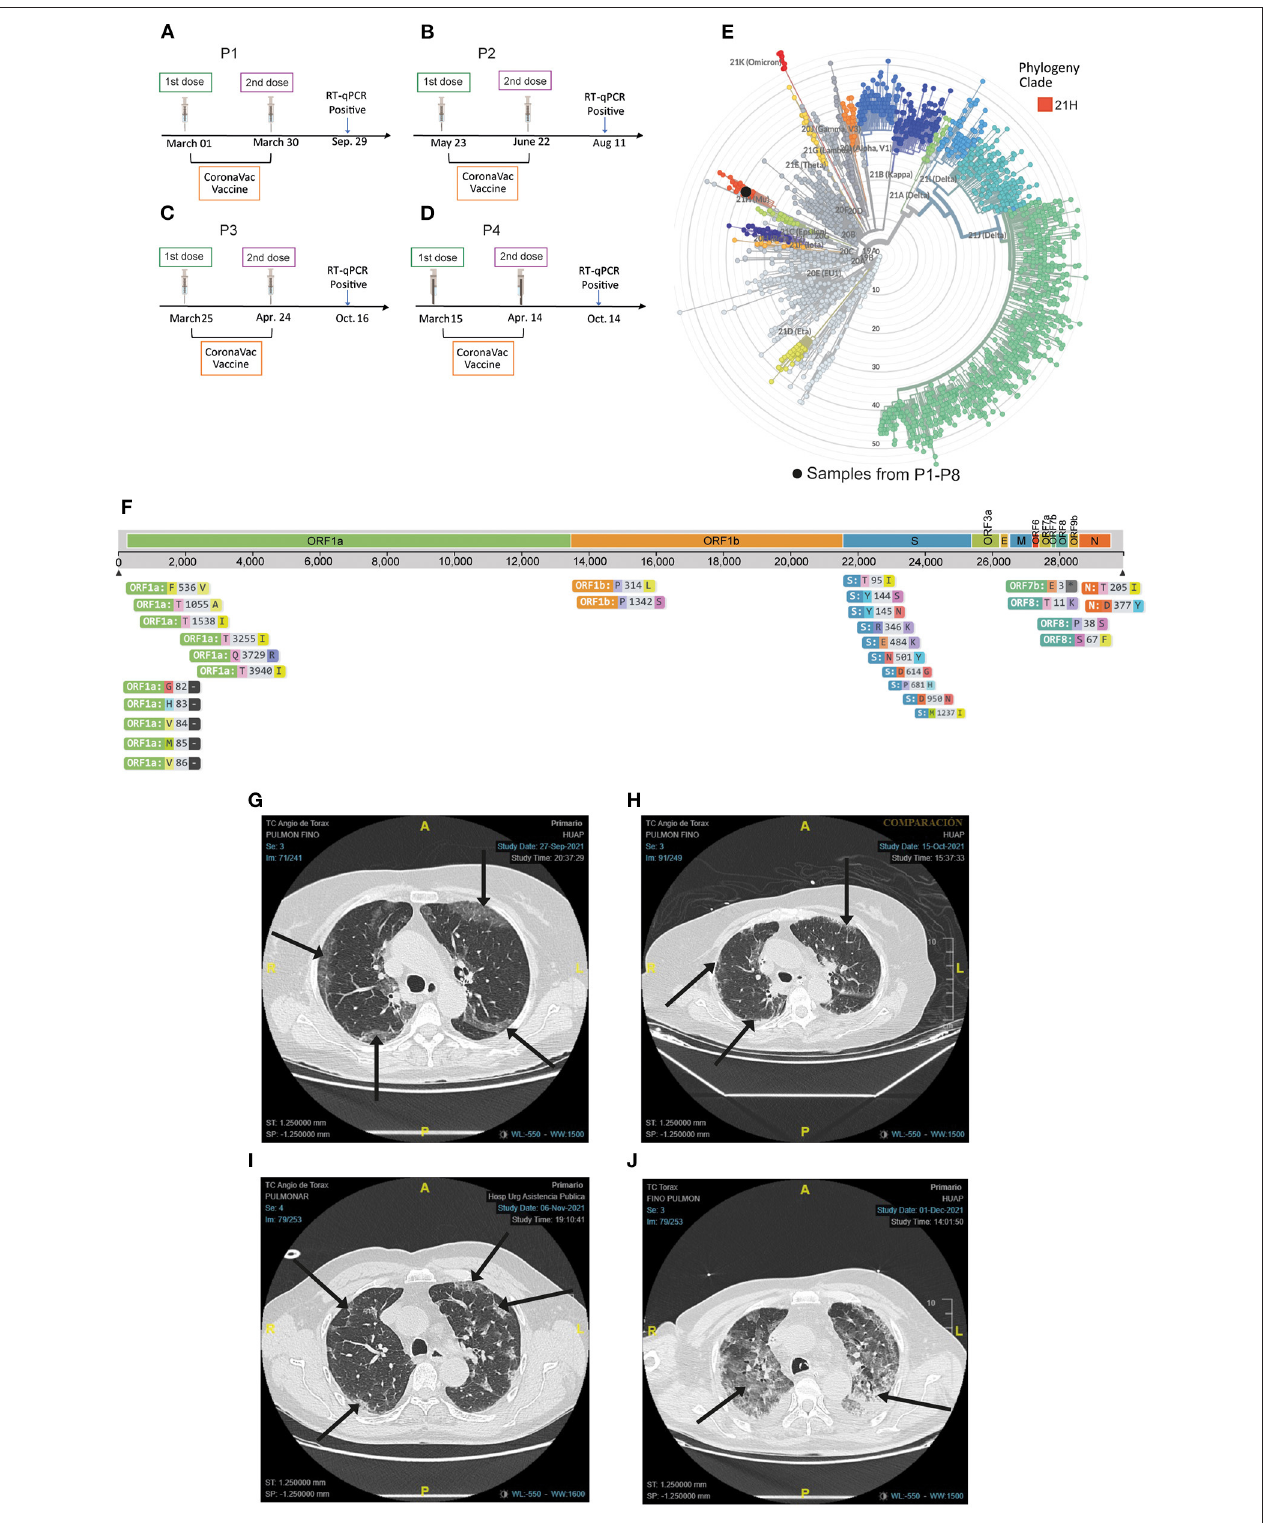
FIGURE 1 | Representative SARS-CoV-2 genome sequencing of the nasopharyngeal swab samples (NPSs) and severity of infection in hospitalized patients. (A–D) Timeline of vaccination scheme from P1, P2, P3, and P4, respectively. (E) Representative phylogenetic tree placement of all NPSs using Nextstrain